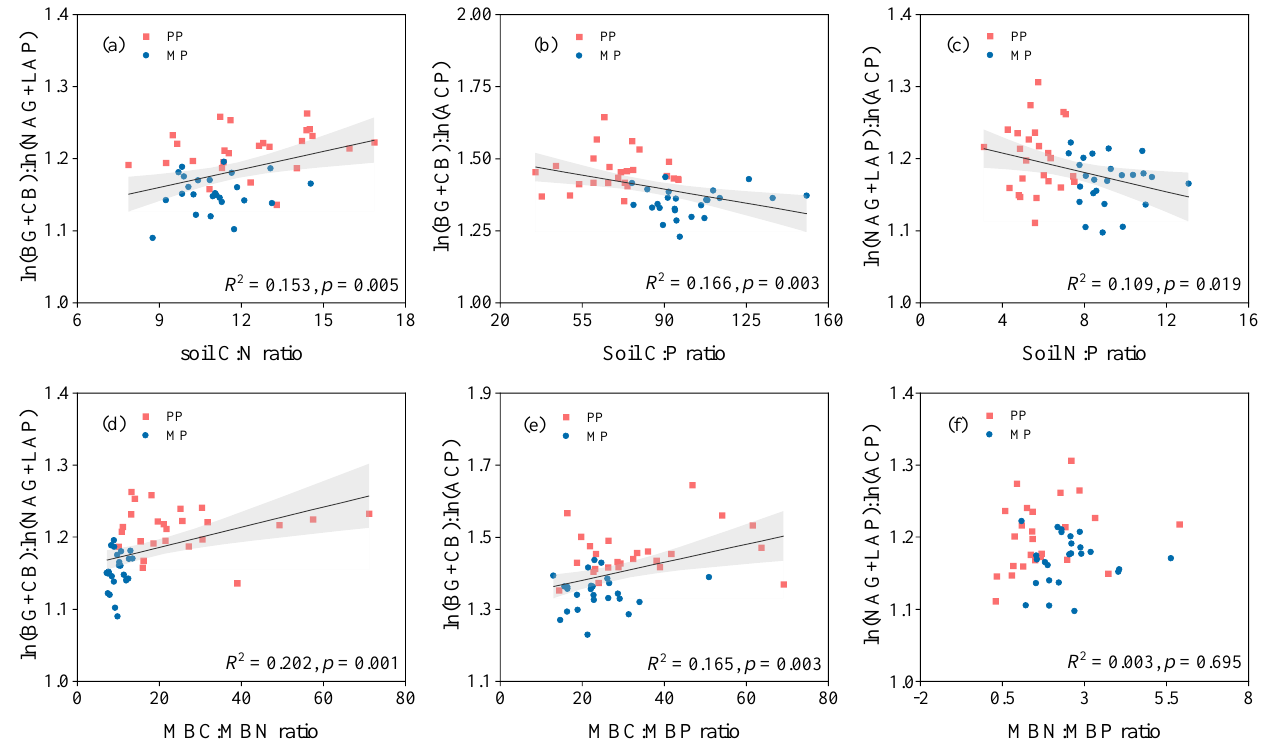
Figure 5. Relationship between soil extracellular enzymatic stoichiometry (EES) and soil nutrient stoichiometry ratios ( a – c ), and microbial biomass stoichiometry ratios ( d – f ). The RDA revealed that soil physicochemical characteristics, LF, and microbial characteristics together explained the total variation in EEA and EES. Specifically, the first and second axis explained 77.45% and 1.46% of the total effect in EEA, respectively (Figure 6a). More than 75% of the effect in EEA was explained by 14 factors (sum of Lambda-B in Table 4), with NO 3 – -N ( F = 95.2; p = 0.002), TN ( F = 9.2; p = 0.002), and MBC:MBP ( F = 4.4; p = 0.018) significantly ( p < 0.05) correlated with EEA (Figure 6a; Ta- ble 4). Furthermore, the first and second axis explained 44.88% and 4.22% of the total ef- fect in EES, respectively (Figure 6b). The 14 variations jointly explained almost 50% of the effect in EES (sum of Lambda-B in Table 5). Finally, forward selection of the 14 varia- tions in the RDA demonstrated that EES was affected mainly by LF ( F = 29.6; p = 0.002) (Figure 6b; Table 5).